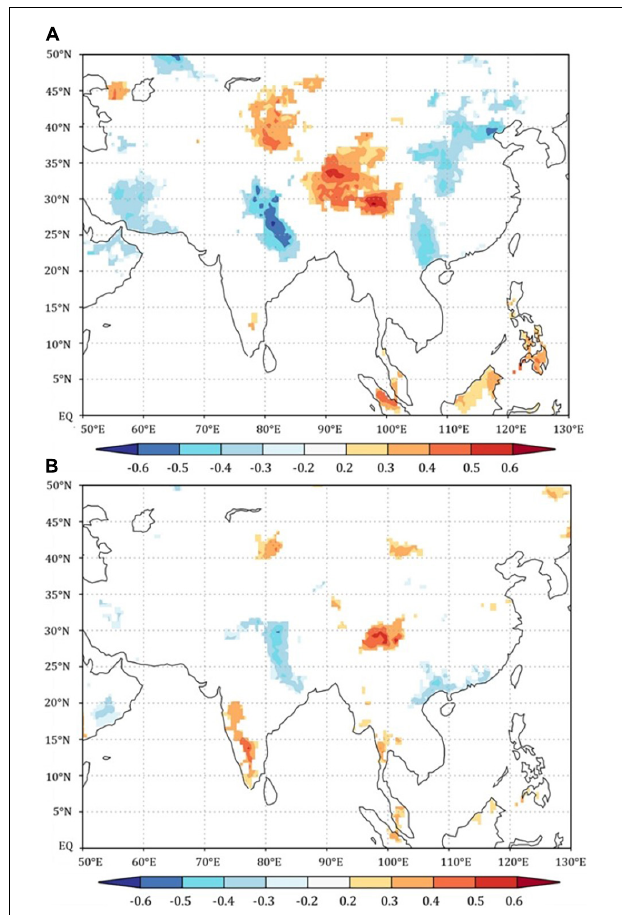
FIGURE 7 | (A) Spatial correlation between the reconstructed SCE 3 − 5 and the corresponding months’ gridded PDSI data for 1955–2013. (B) Same as (A) but between EWW and March-April-May gridded PDSI data for 1955–2013. The images were generated using the climate explorer program.